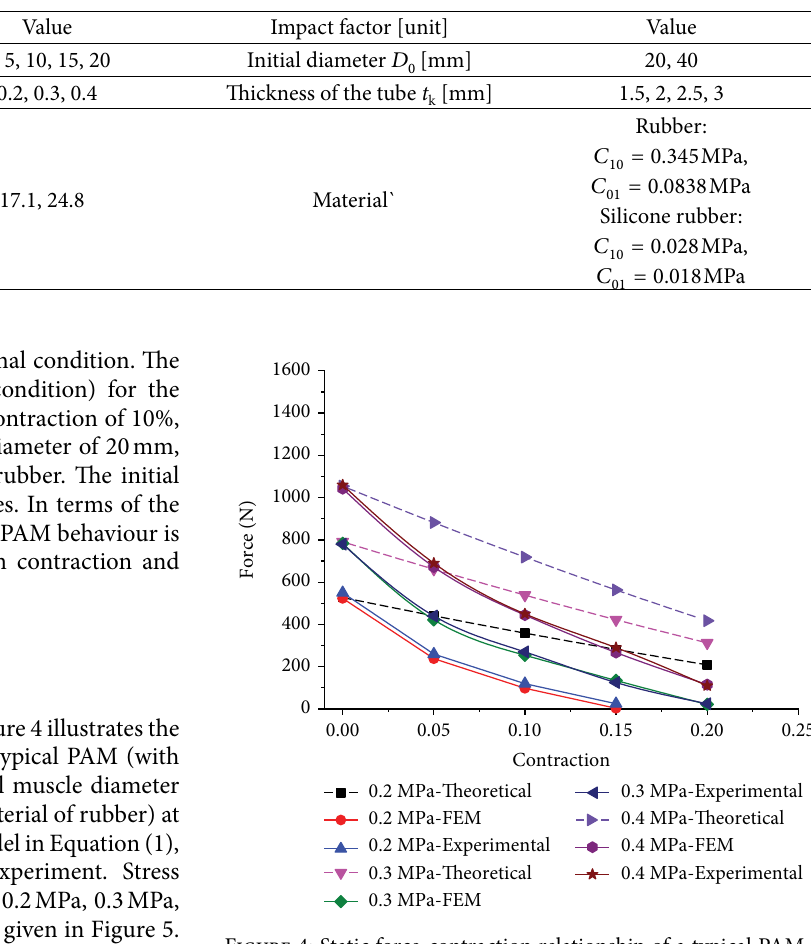
Table 1: Impact factors for the characteristics of PAM.